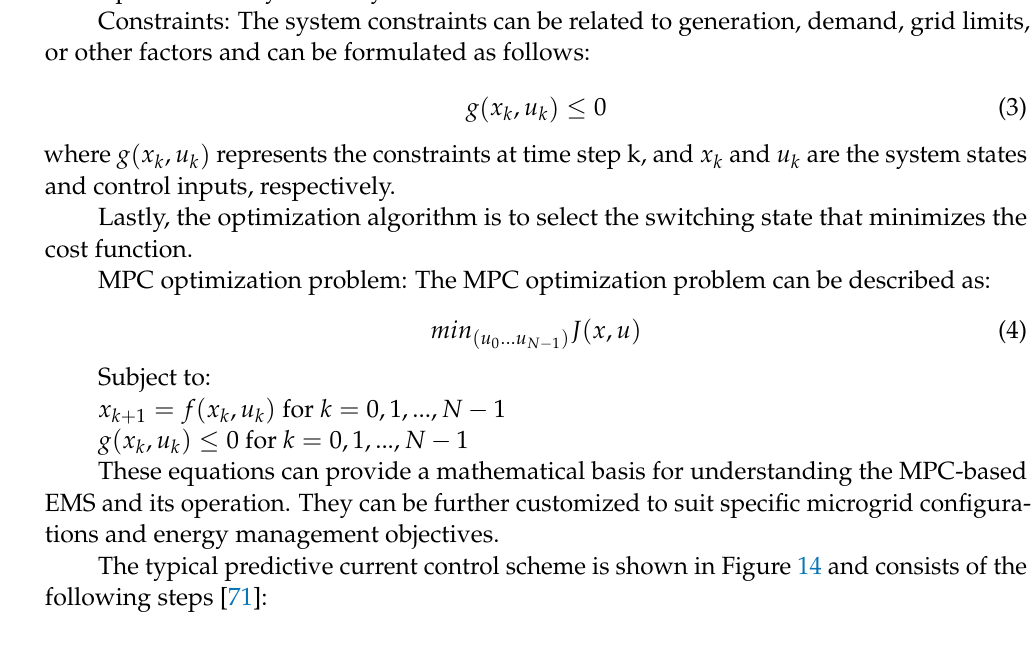
Figure 13. Typical MPC control scheme in AC MG.